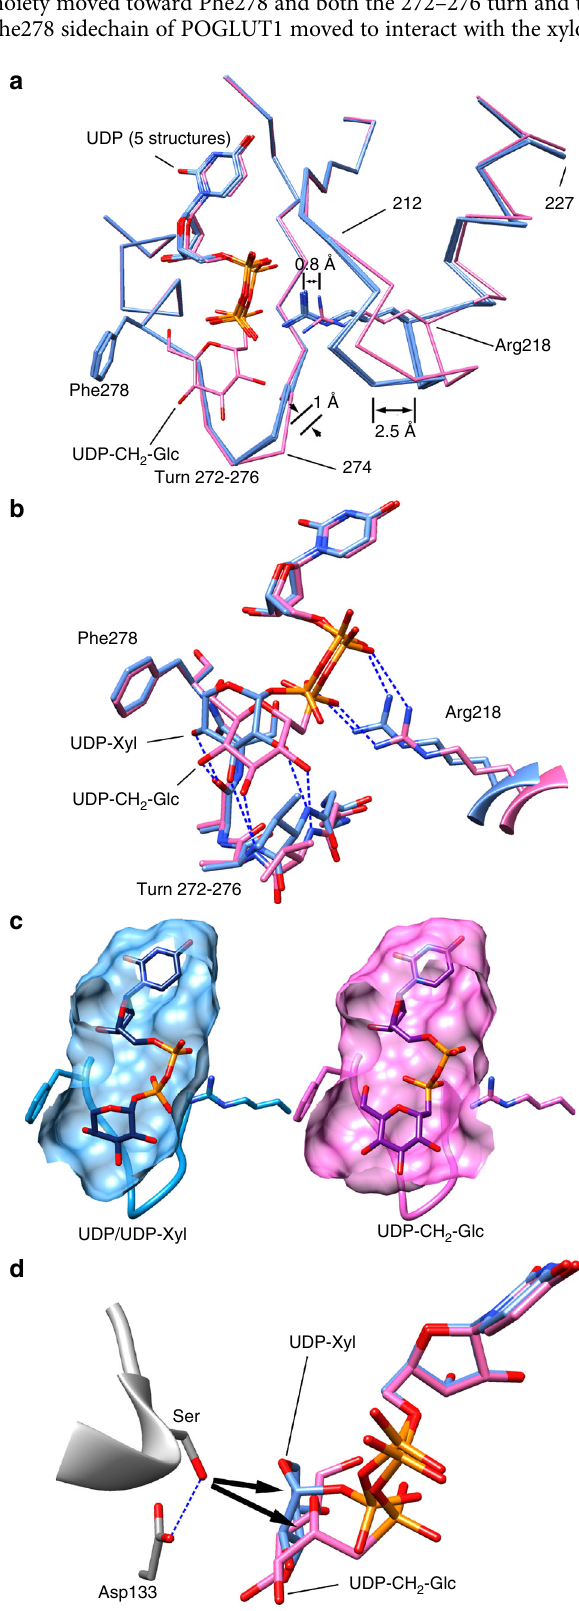
Fig. 4 Two local conformational states of the glucose subsite and docking of UDP-xylose. a The UDP-CH 2 -glucose complex ( pink ) compared to the fi ve UDP-bound structures ( light blue ). b UDP-xylose docked into the UDP conformation ( light blue ), compared to the UDP-CH 2 -glucose complex ( pink ). c Comparison of the binding pocket of the UDP bound state ( left , showing a docked UDP-xylose) and the UDP-CH 2 -glucose bound state ( right ). d Superimposition of the docked UDP-xylose ( blue ), the co- crystallized UDP-CH 2 -glucose ( pink ), and the hF7EGF1 complex (showing the acceptor Ser and the catalytic base Asp133). The two arrowheads indicate the direction of nucleophilic attack for glucosylation